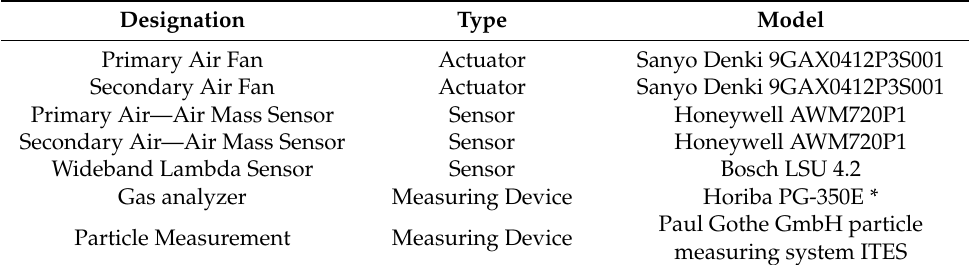
Table 2. Sensors, actuators and measuring devices used in the experiments. Type